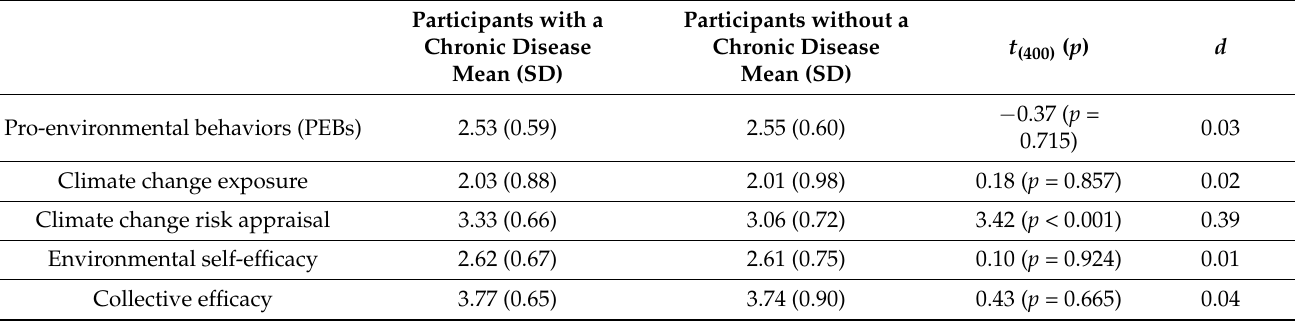
Table 3. Means, SDs, and t values for the study variables by chronic disease ( n =